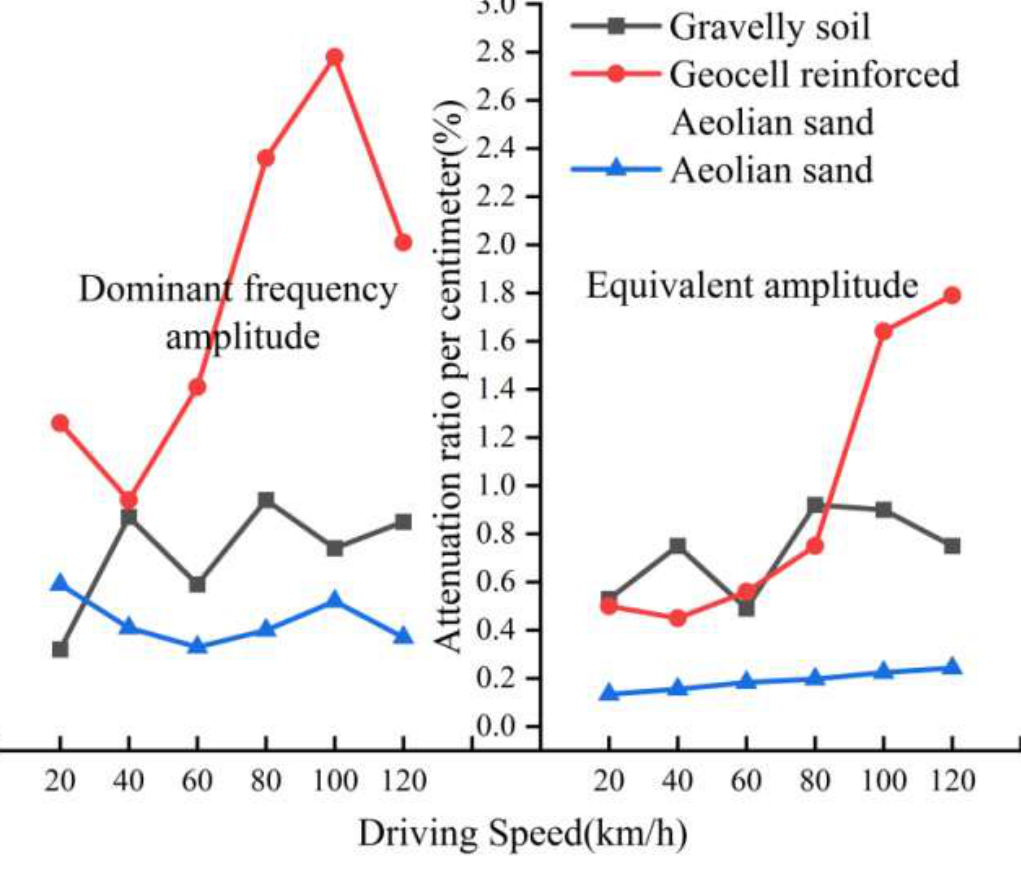
Figure 15. Vibration velocity attenuation performance curve.